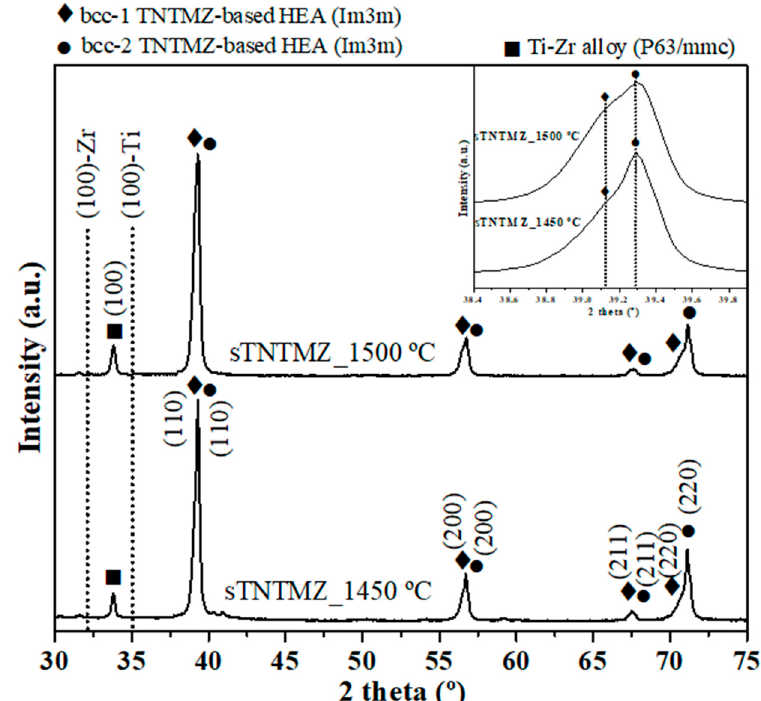
Figure 6. XRD patterns of the sintered sTNTMZ_1450 ◦ C and sTNTMZ_1500 ◦ C specimens. Between brackets: the crystallographic planes for each phase. Dotted lines are used to mark the position of the (100) crystallographic plane position for hcp-Ti and hcp-Zr. Inset: Magnification of the XRD patterns in the 38.4–39.9 ◦ 2 θ range. Dotted lines are used to mark the invariant position of the (110) crystallographic planes for both bcc-1 and bcc-2 phases.